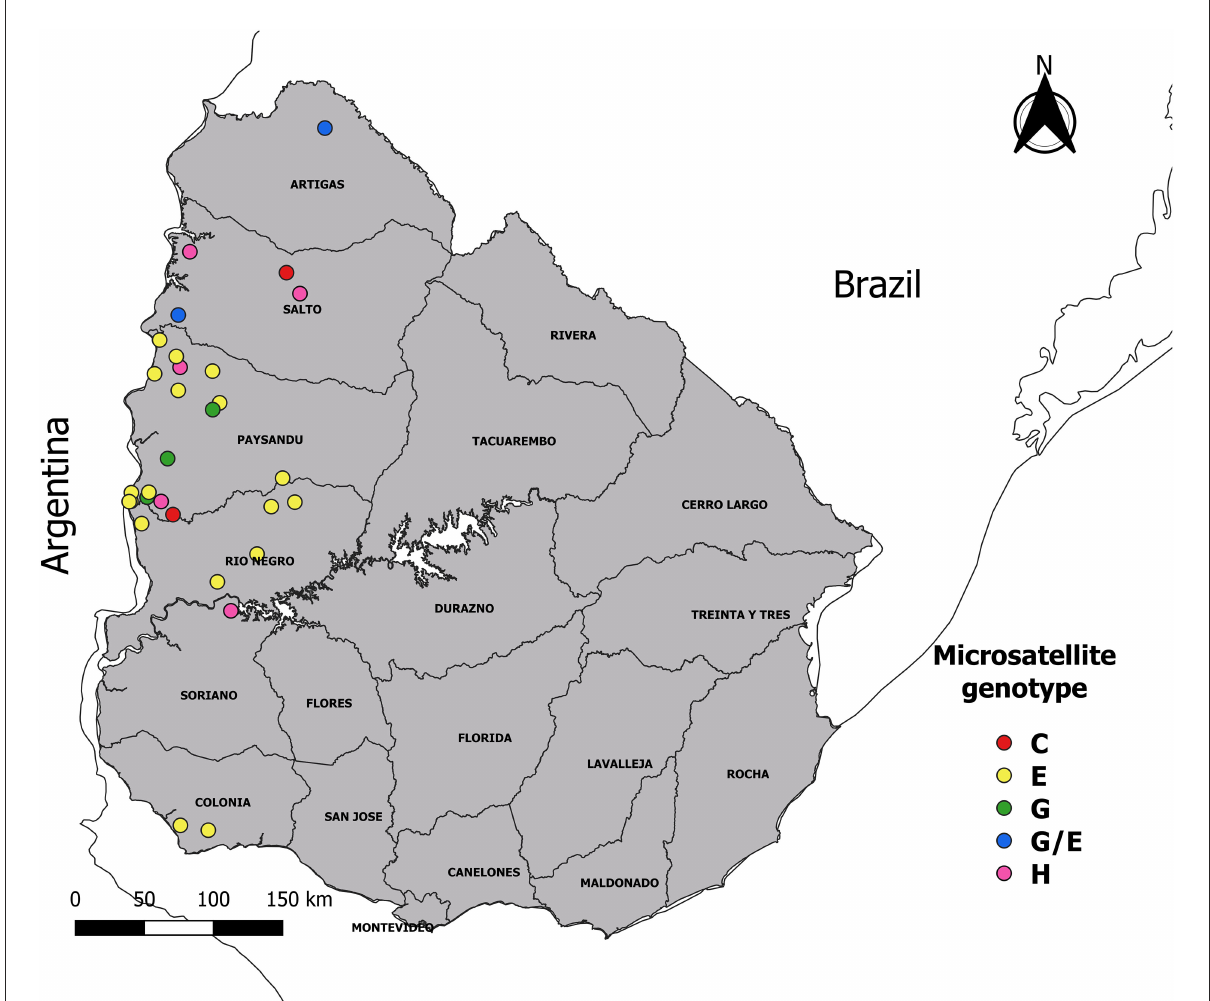
FIGURE1 Map showing geographic location of the samples. The 60 samples of infected animals with Anaplasma marginale were obtained from 30 outbreaks of bovine anaplasmosis (dots with different color according to microsatellite genotype), distributed in six departments of